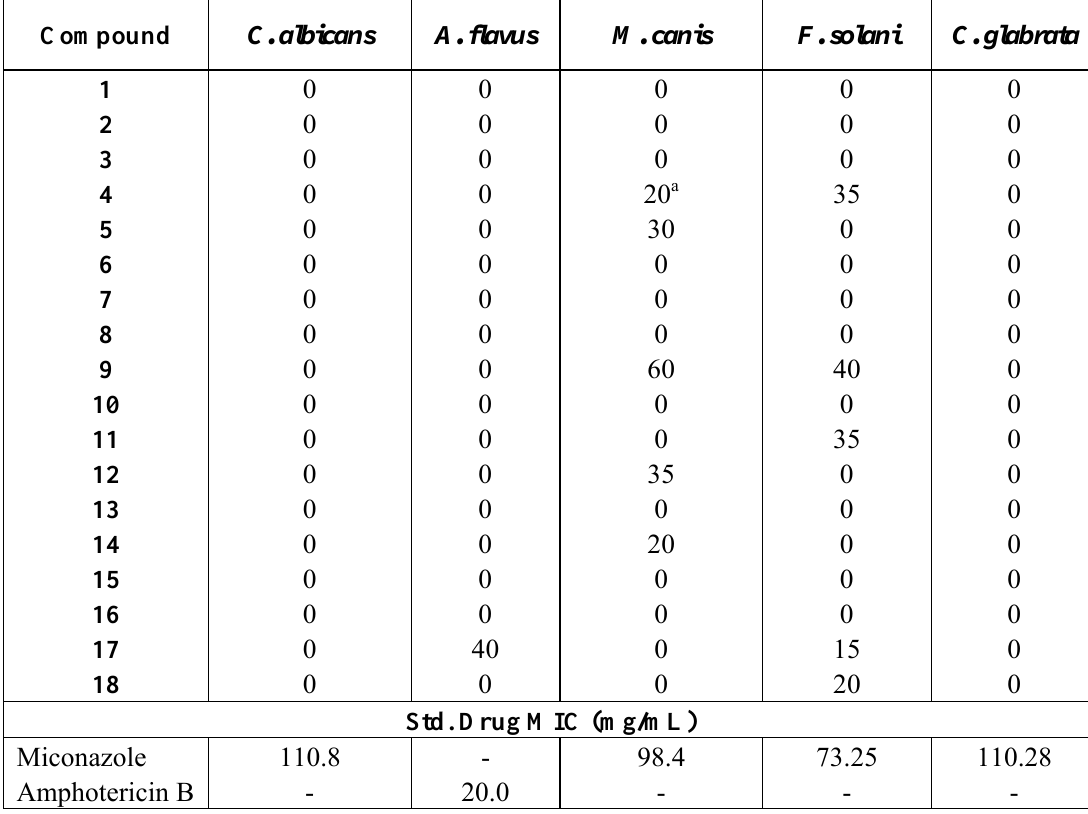
Table 6. % inhibition of azomethines against different types of fungi.